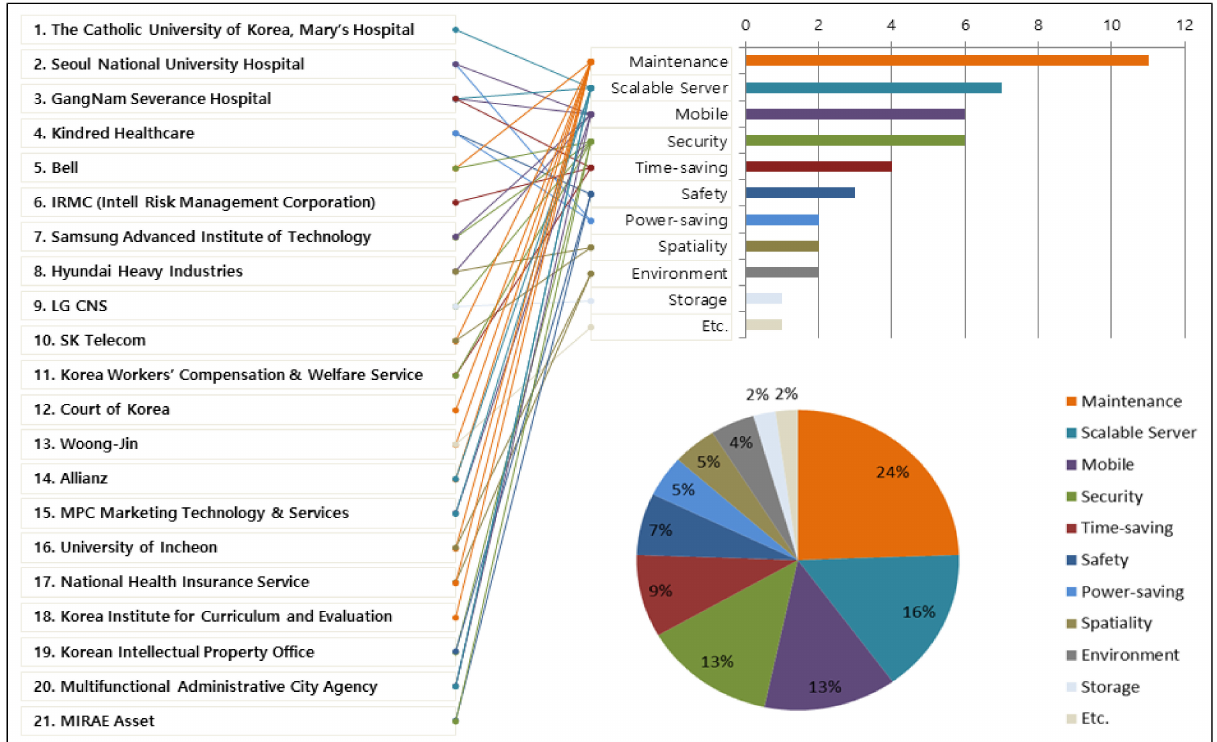
Figure 1. Chart of the analysis of virtual computing usage in other